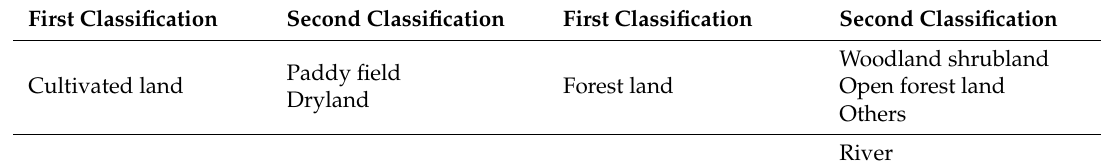
Table 1. Land-use / land cover classification